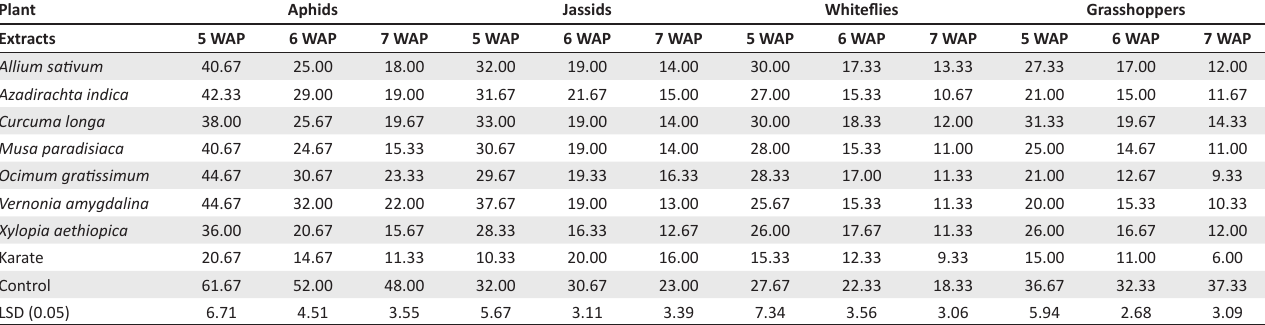
TABLE 2: Mean population densities of insects on mung bean treated with plant extracts and karate in 2015 cropping season. Plant Aphids Jassids Whiteflies Grasshoppers Extracts Azadirachta indica